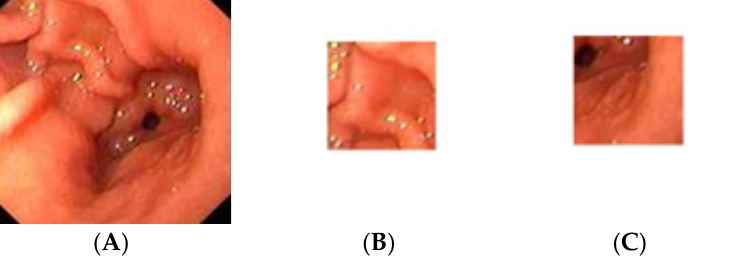
Figure 2. Sample of the normal gastric image cropped into 20 ROIs; ( A ) normal gastric, ( B ) normal ROI_1, ( C ) normal ROI_20.